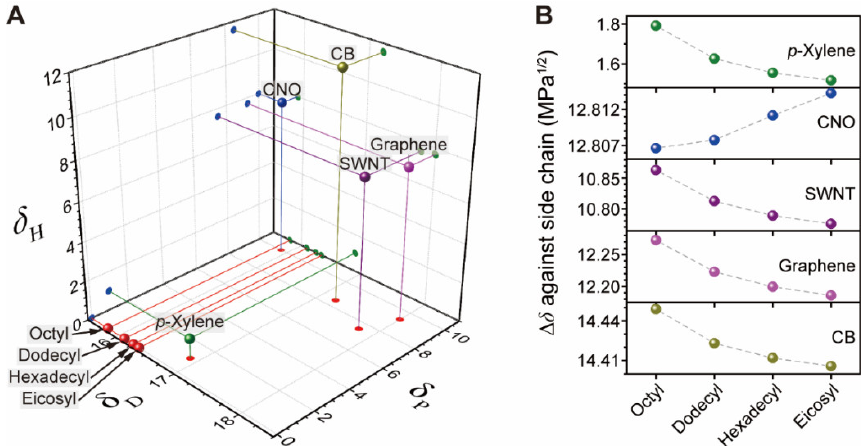
Figure 8. Comparison of δ and its subcomponents for flavin side chains, p -xylene and representative nano carbon allotropes. ( A ) Comparison of each entity in terms of δ D , δ P , and δ H . ( B ) Δ δ of p -xylene and nano carbon allotropes against l S of flavin.